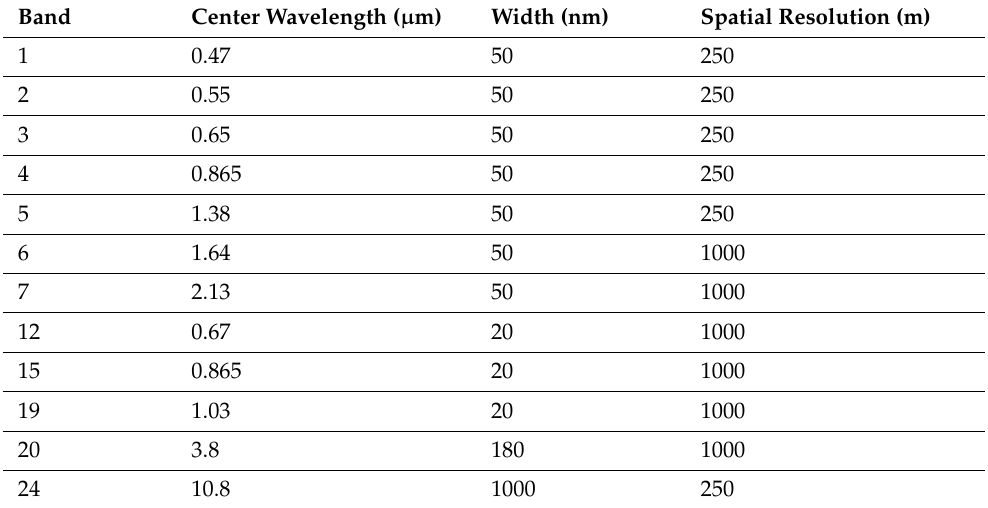
Table 1. The wavelengths of the FY3D/MERSI-II instrument used in the